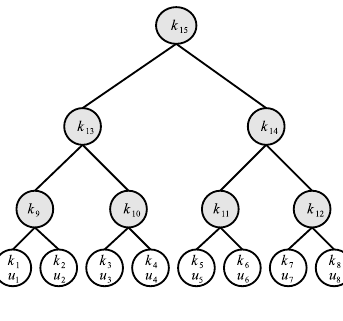
Fig. 1. Key tree of